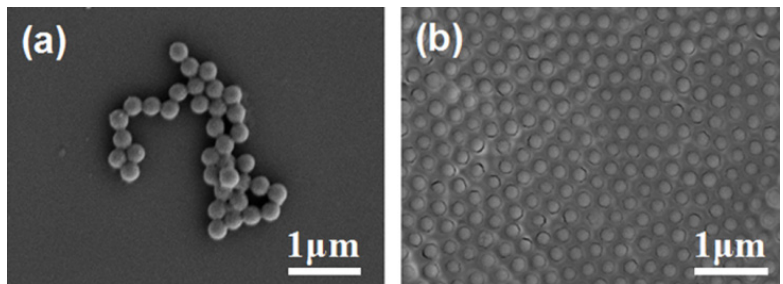
Figure 1. Scanning electron microscope (SEM) images of the poly(styrene-co-acrylic acid) (PSA) microspheres assembled in ( a ) zinc acetate (ZA) solution and ( b ) citric acid-zinc acetate (CA-ZA) solution (CA/ZA molar ratio = 1:1).